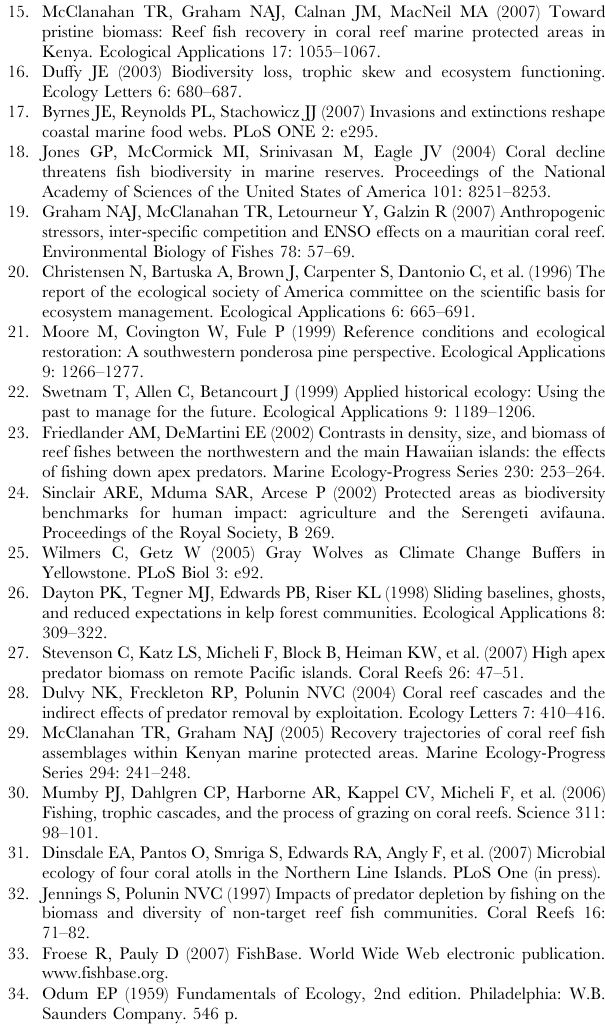
Table S4 Non-coral invertebrate data analysis: Median test for comparison of species abundance between atolls.